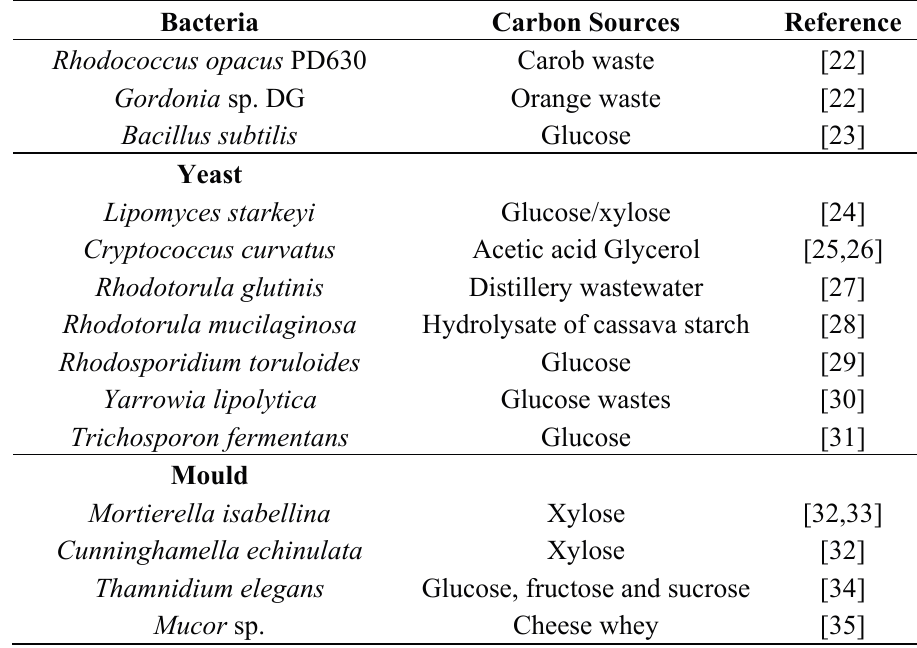
Table 1. Examples of cultivation of oleaginous